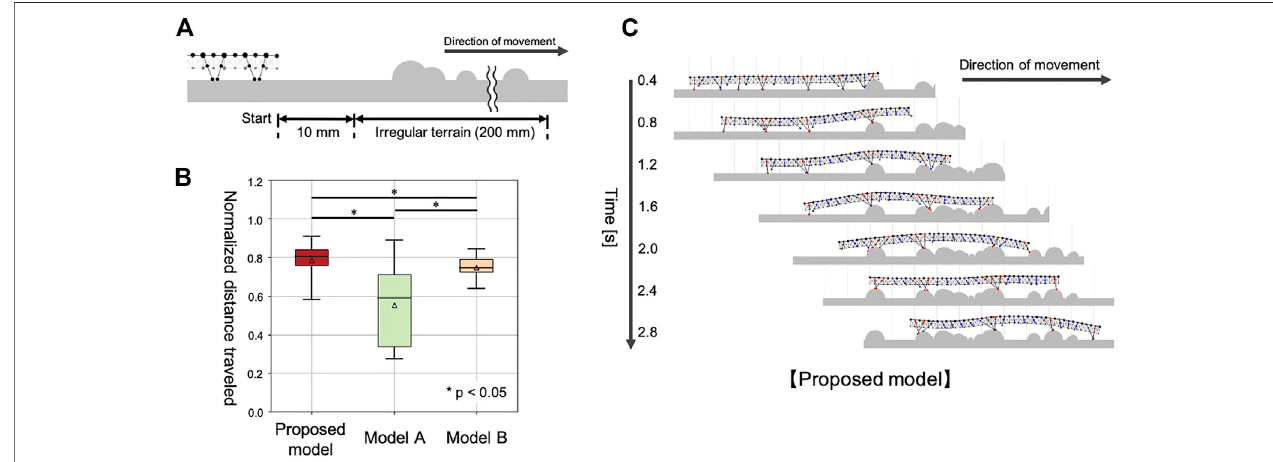
FIGURE 7 | Simulation results for walking on irregular terrain with many obstacles. (A) Schematic of the experimental setup. (B) Comparison of the walking performance with different models. (C) Snapshots of the representative simulated walking using our proposed model.